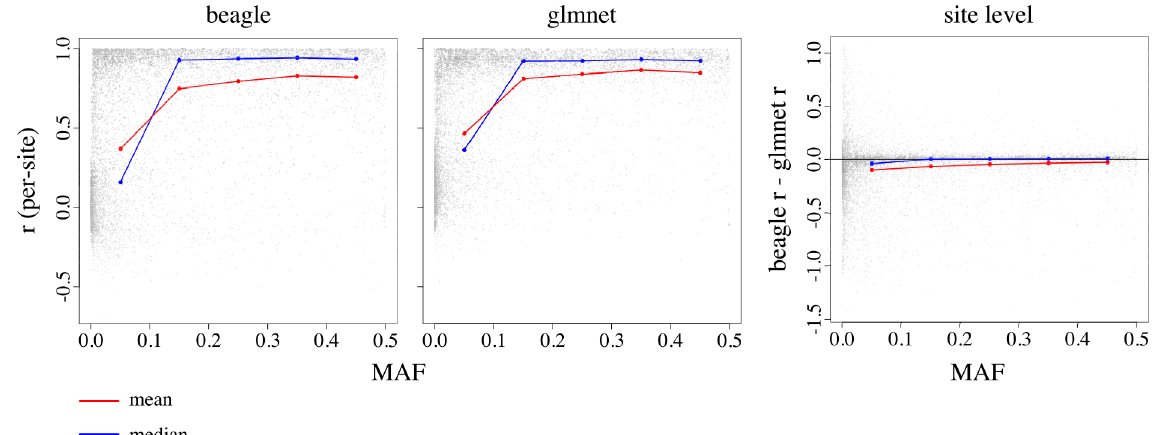
Fig 4. Imputation accuracy as a function of MAF. The left and middle panels show per-site accuracy of Beagle and glmnet as a function of (estimated) MAF. The right-most panel shows the difference in accuracy between Beagle and glmnet at each site as a function of MAF. We observed the greatest difference in accuracy at low-frequency variants. Low-frequency variants were imputed with high